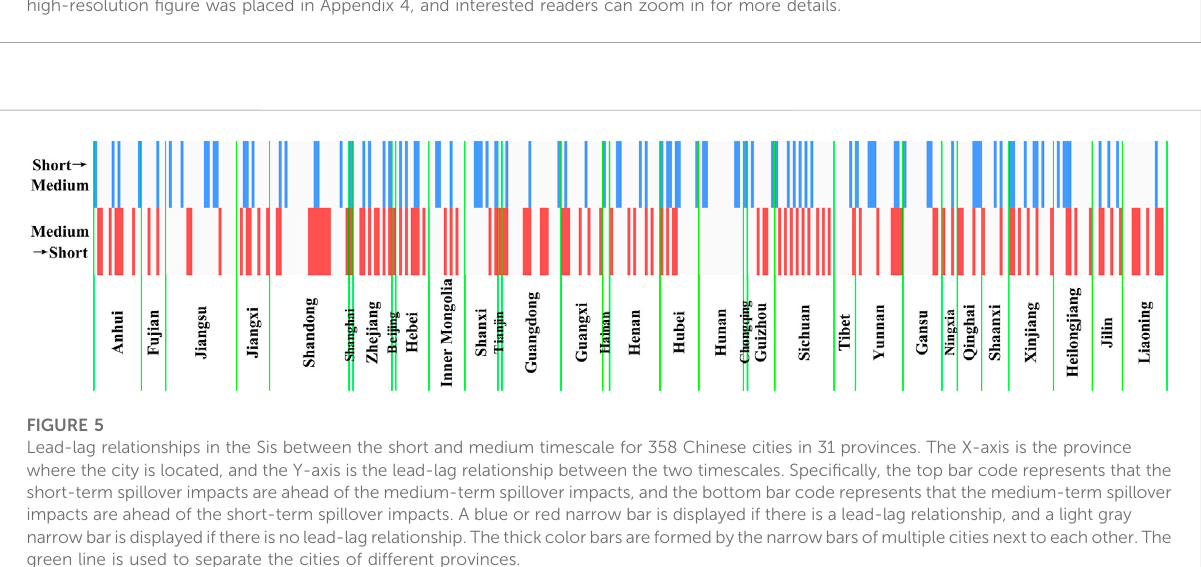
Heatmaps of cities ’ spillover impacts. Panels (A – C) represent the results of the undecomposed data, the short term, and the medium term, respectively. TheX-axisrepresentsthesliding window, andtheY-axisisthecity.Only20representativecitiesarepresentedineachpanel,wherethe ten most in fl uential cities are on the top half of each panel, and the ten least in fl uential cities are on the bottom half of each panel. The full-size and high-resolution fi gure was placed in Appendix 4, and interested readers can zoom in for more details.